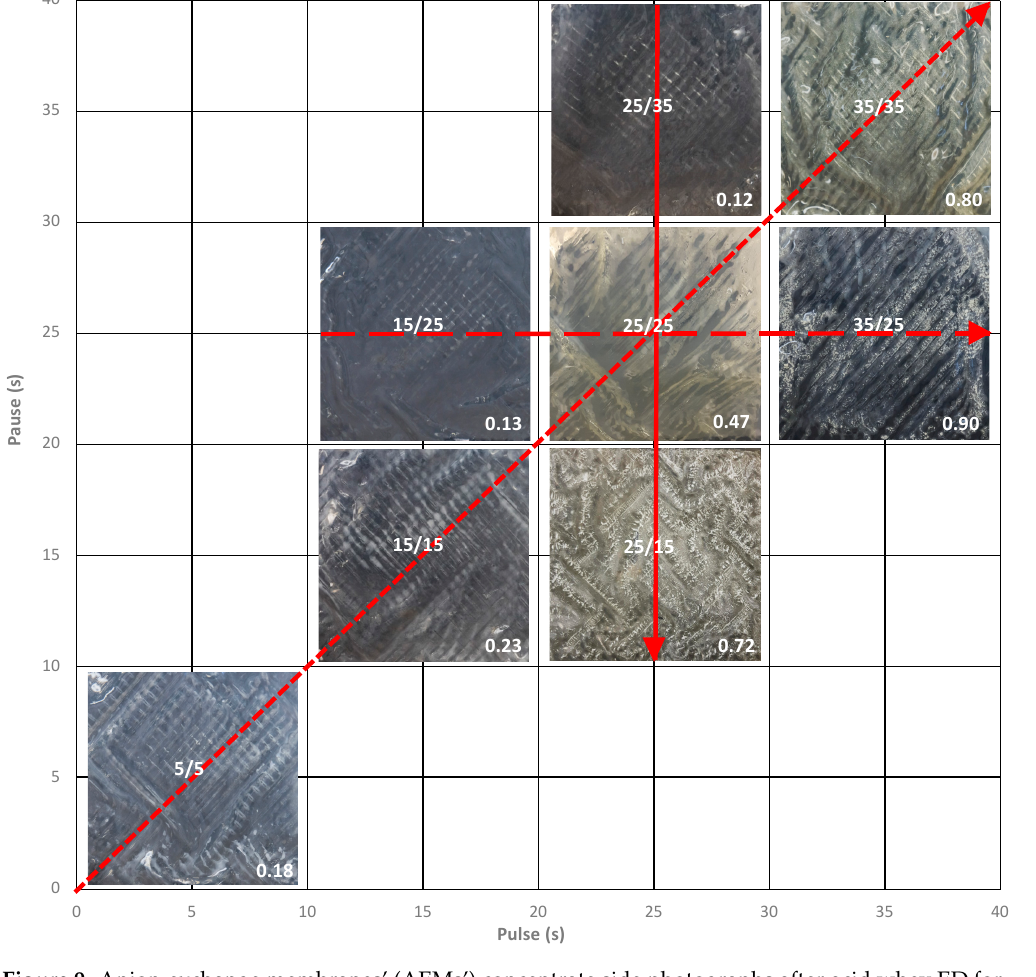
Figure 9. Anion-exchange membranes’ (AEMs’) concentrate side photographs after acid whey ED for the eight PEF treatments. The membranes represented are either A1 or A2 as there were no visible differences between them for the same condition. The scaling increasing intensity for PEF pause duration, pulse duration, and frequency variations are represented by the solid arrow, the long dots arrow, and the short dots arrow, respectively. The values in the corners are the amount of scaling on the AEMs (in g/100 g of dry membrane).